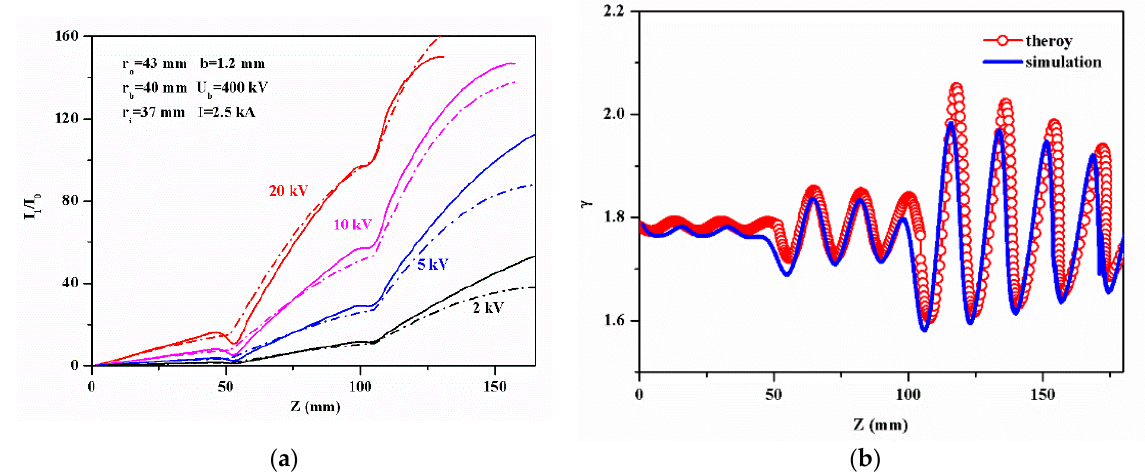
Figure 6. The modulation model of first, second and third bunching cavity: 1—cathode, 2—input cavity, 3—second bunching cavity.